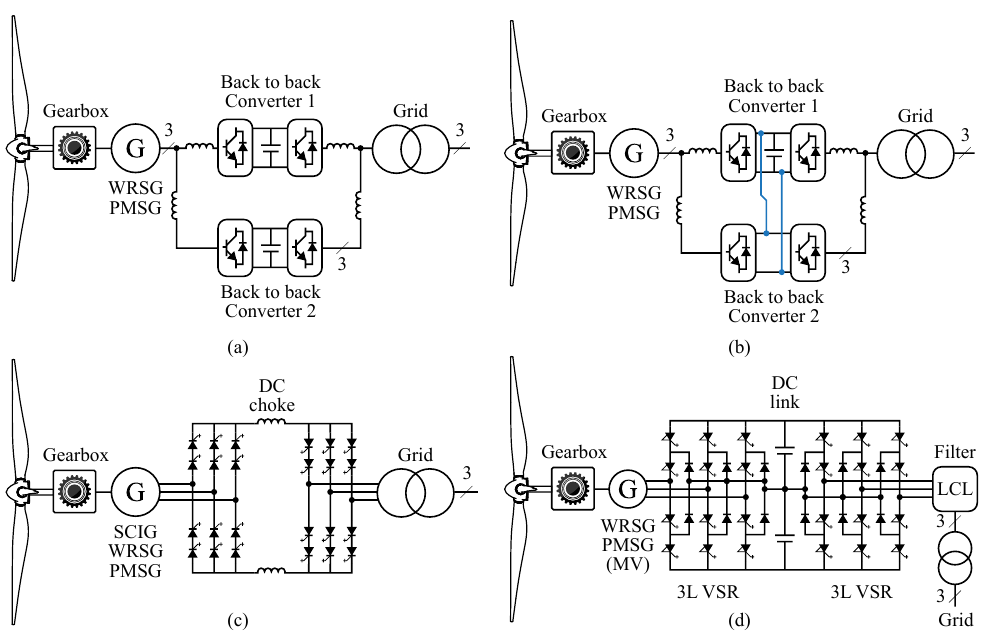
Figure 6. ( a ) Parallel BTB converter with individual dc-link. ( b ) Parallel BTB converter with common